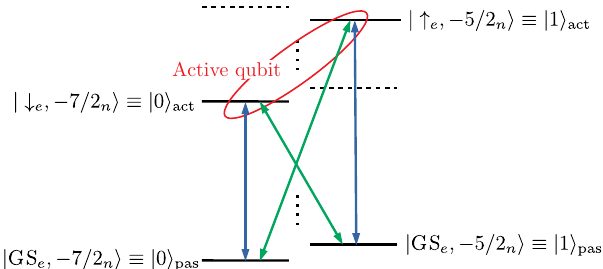
FIG. 10. Sketch of our choice of passive and active qubits in 167 Er 3 + :Y 2 SiO 5 . The nuclear spin states denote the projections in the electronic polarization directions, i.e., they are not the same for the ground state and excited doublets. Because of the simi- lar g -factor anisotropies in the ground and excited doublets, the transitions indicated with blue arrows are a factor of 3.5 faster than the transitions indicated with green